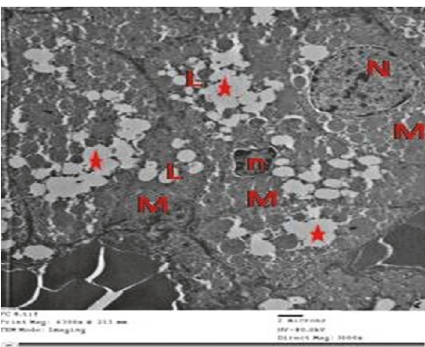
Figure 14: An electron micrograph showing fasciculata cells from group IV showing cells with euchromatic nuclei (N) with regular outline (arrow), numerous mitochondria with intact cristae (M), and numerous lipid droplets (L). Note some confluent lipid droplets (stars) and the irregular shrunken hyperchromatic nucleus